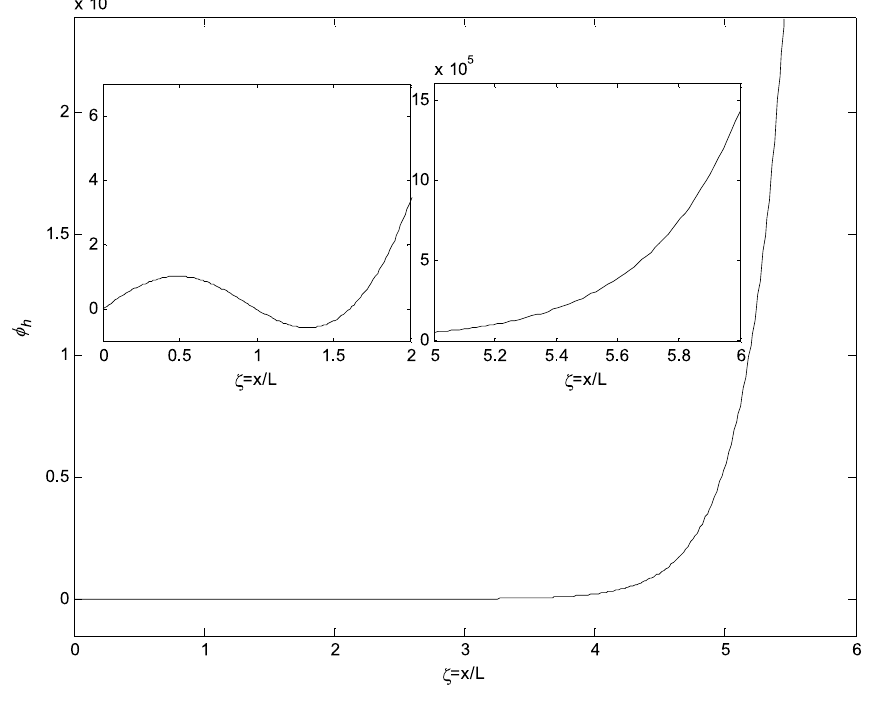
Fig. 7. Homogenous part of the second mode shape for six-span beam.